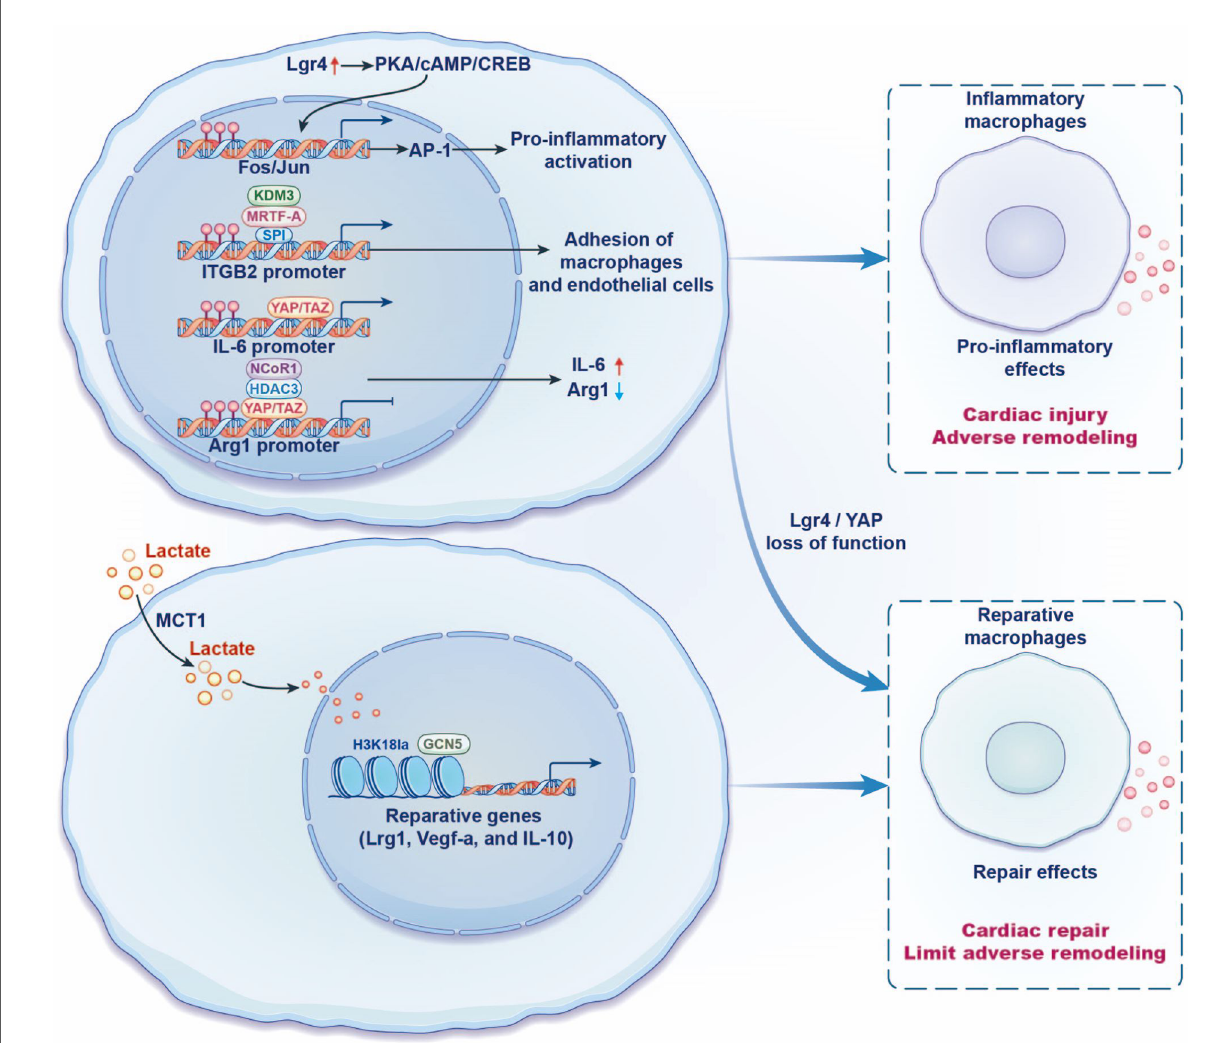
FIGURE 2 Regulation of recruited macrophage phenotypes and function in heart failure by transcription. Lgr4 promotes the transcription of Fos and Jun families through the cAMP/PKA/CREB pathway, synergistically increases the activity of AP-1, and promotes the downstream proin fl ammatory gene